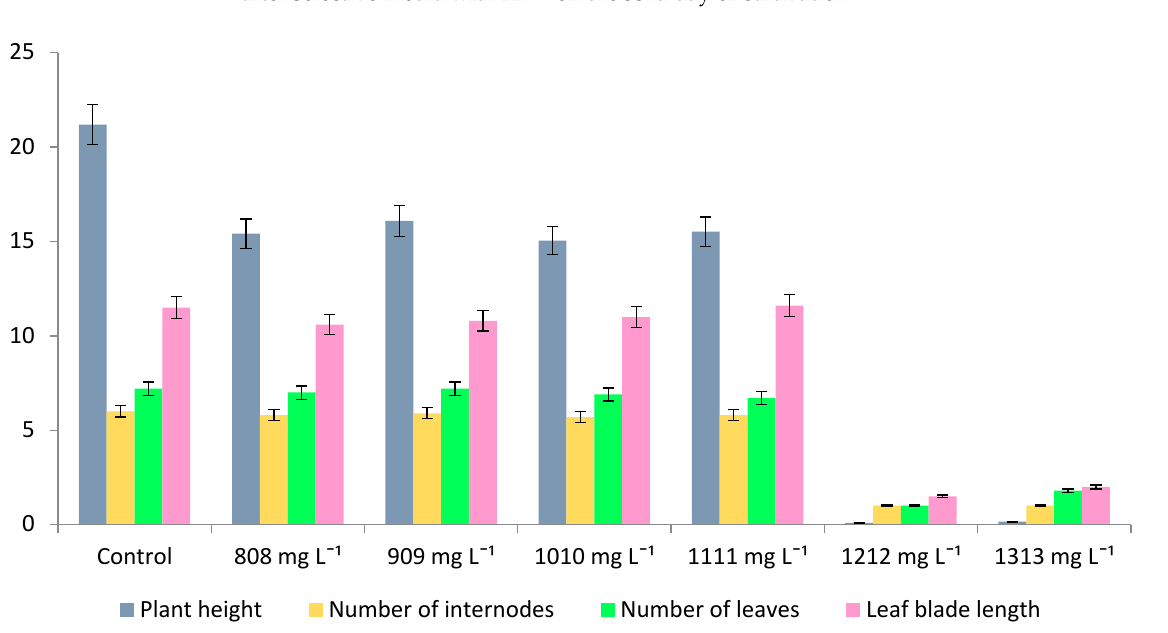
Figure 2. Morphological indicators of buckwheat plants of Izumrud variety on the MS (II passage) after selective media with Zn 2+ on the 33rd day of cultivation.